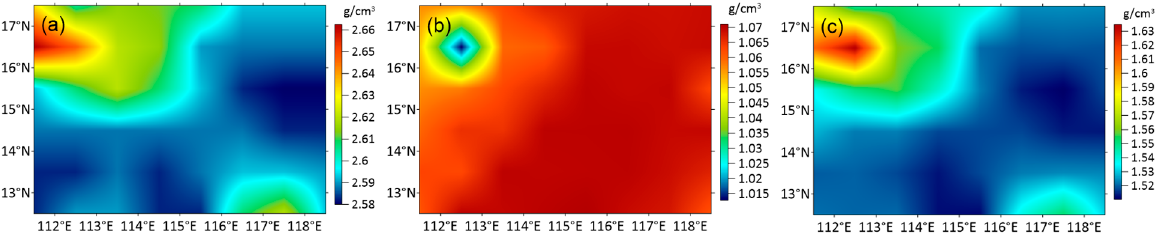
Figure 2. Results of the density model: ( a ) density model of crust, ( b ) density model of seawater, and ( c ) density contrast model.